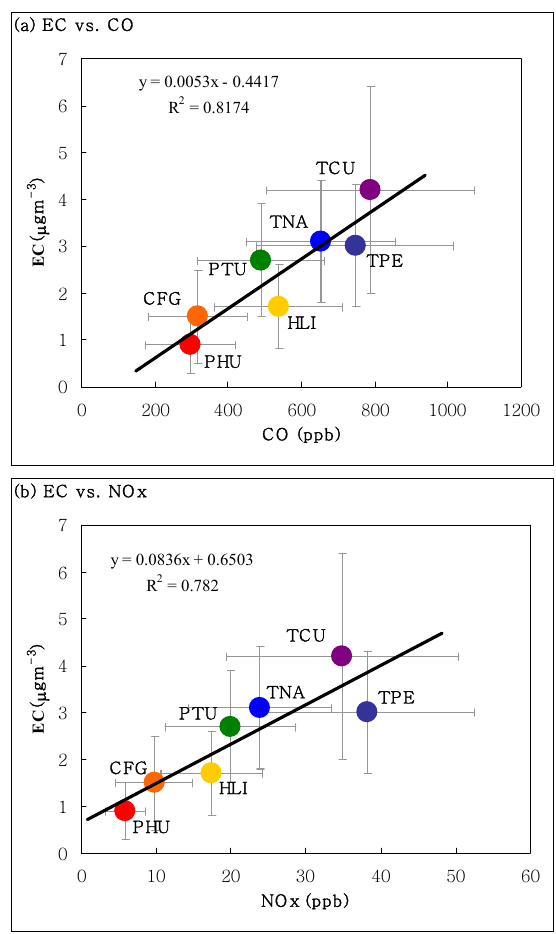
Fig. 7. Correlations between EC and CO (a) , and between EC and NO x (b) across the network stations. The symbols for respective stations were color-coded to assist comparison among (a)–(b) and Fig.